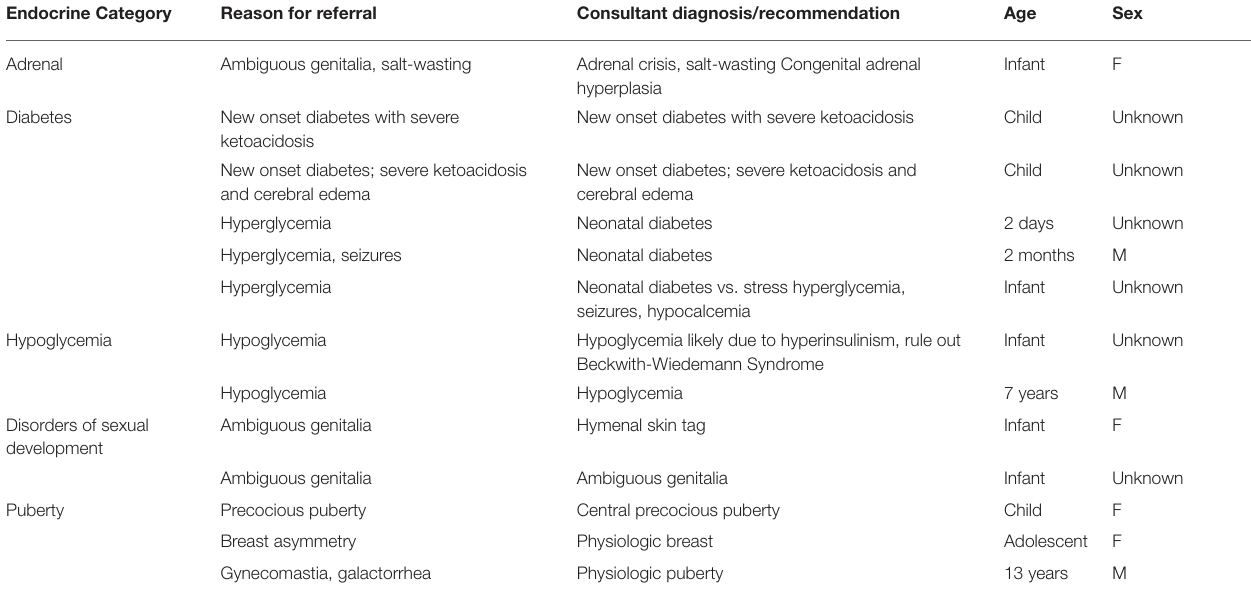
TABLE 5 | Reasons for referral and consultant diagnoses of urgent consultations by endocrine